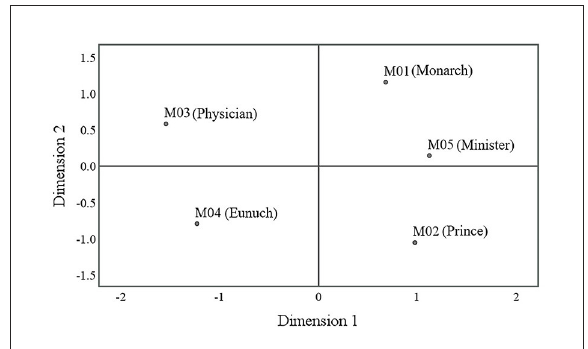
FIGURE6 Multi-dimensional scaling of the character voices.